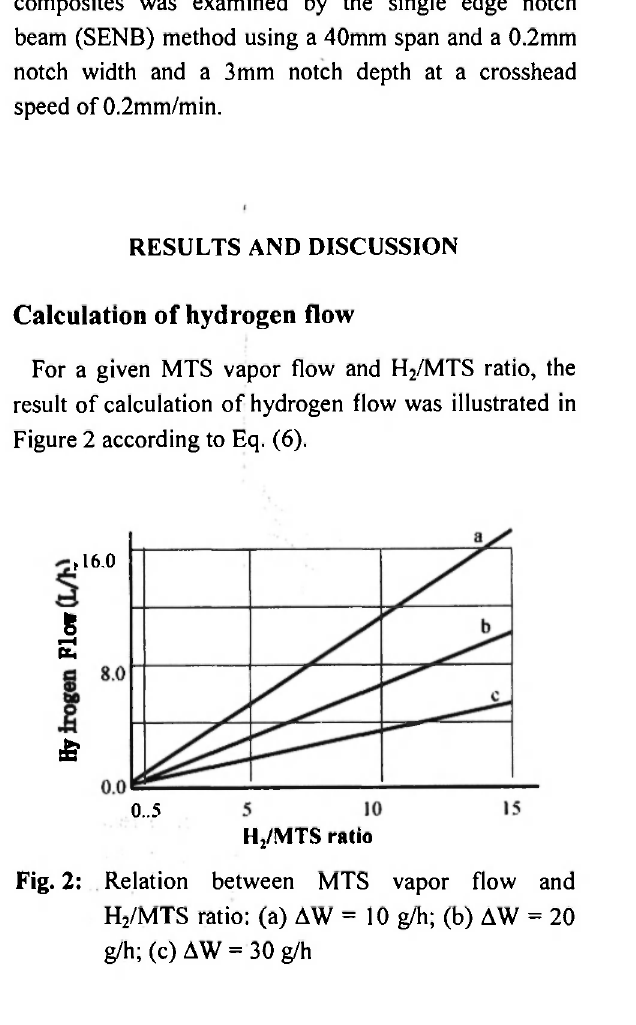
Fig. 2: Relation between MTS vapor flow and H 2 /MTS ratio: (a) AW = 10 g/h; (b) AW = 20 g/h; (c) AW = 30 g/h